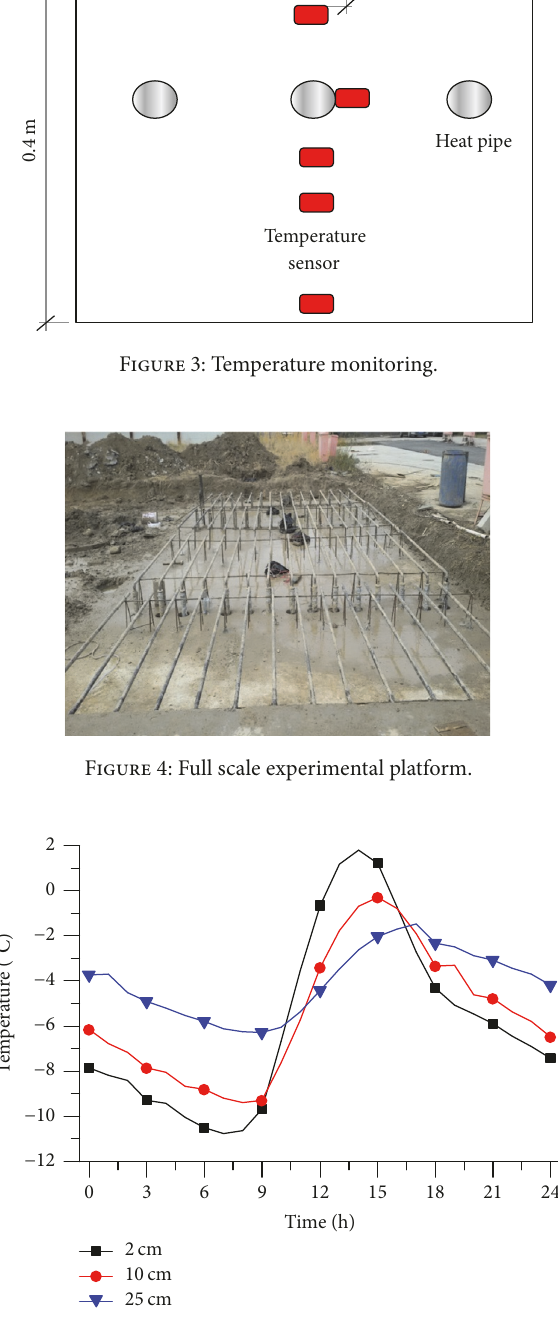
Figure 5: Normal pavement temperature at different times.